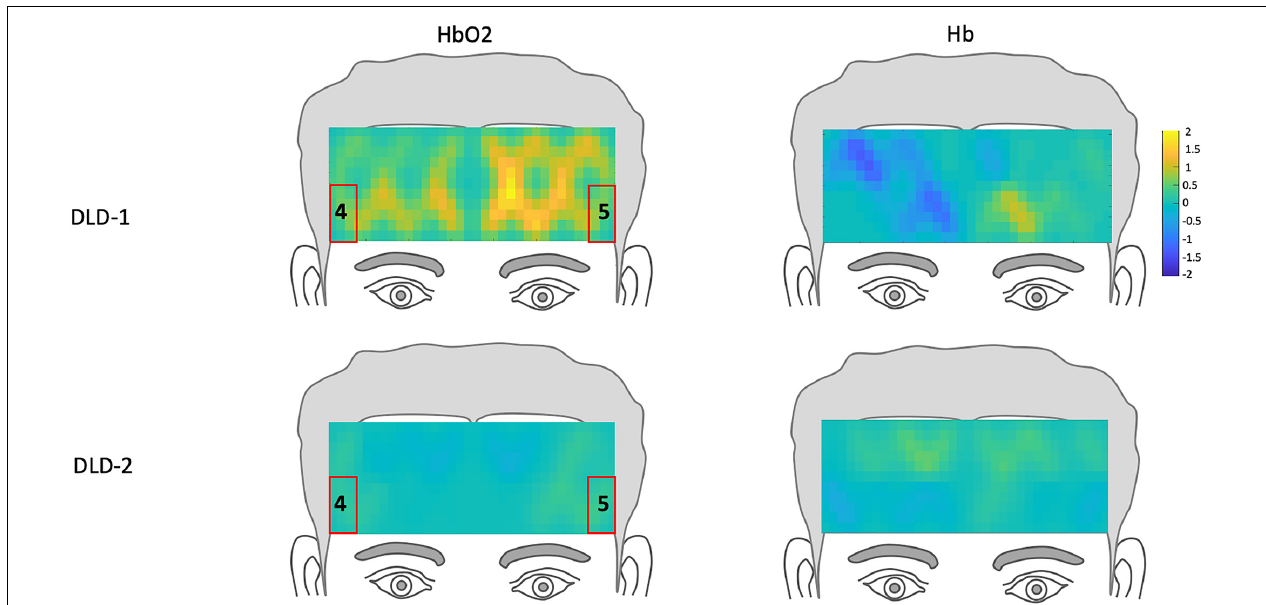
FIGURE 7 | Z -score topographs for DLD-1 and DLD-2 from post-training, for low-frequency words for HbO 2 and Hb. ROIs established by the normal controls are outlined in